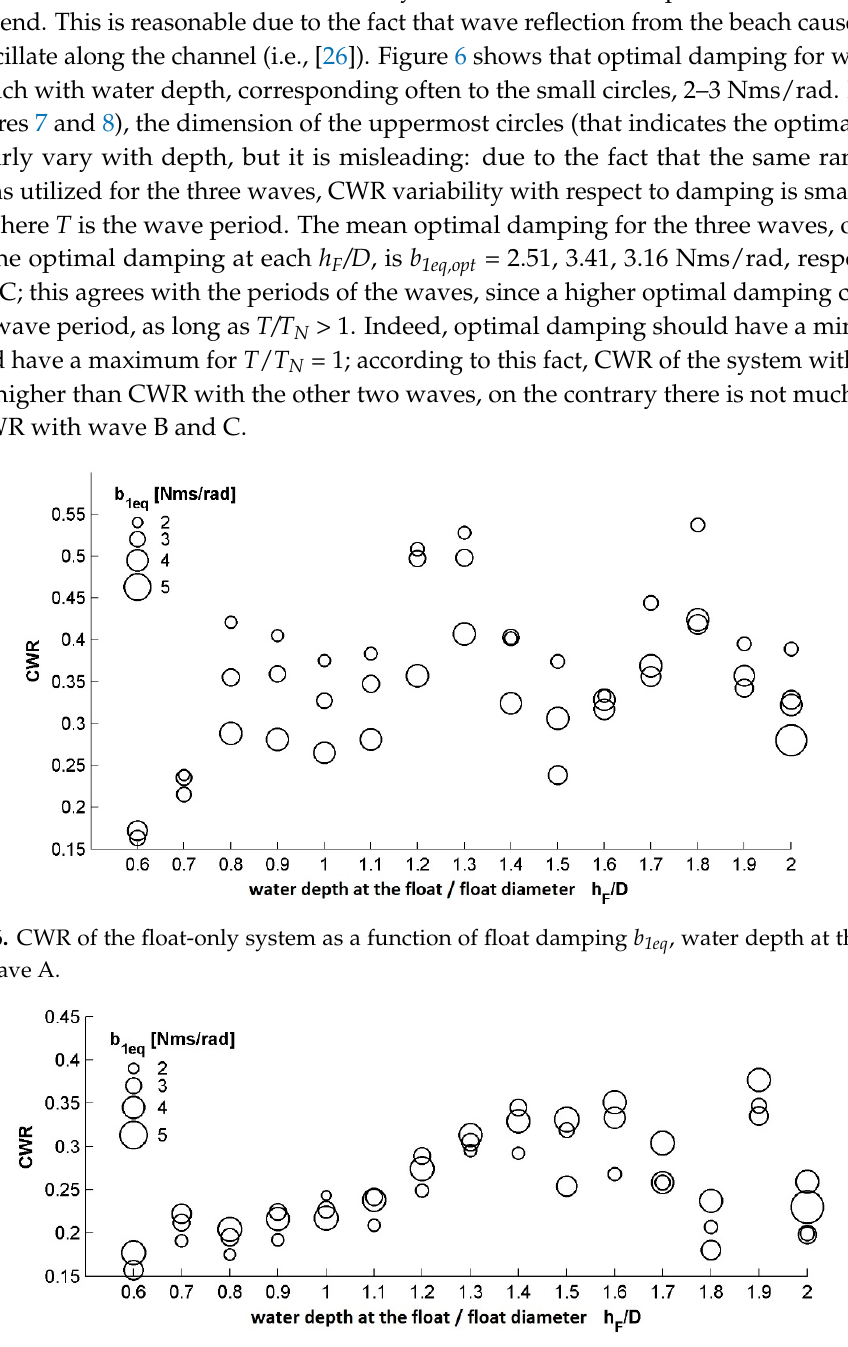
Figure 7. CWR of the float-only system as a function of float damping b 1eq , water depth at the float h F /D . Wave B.